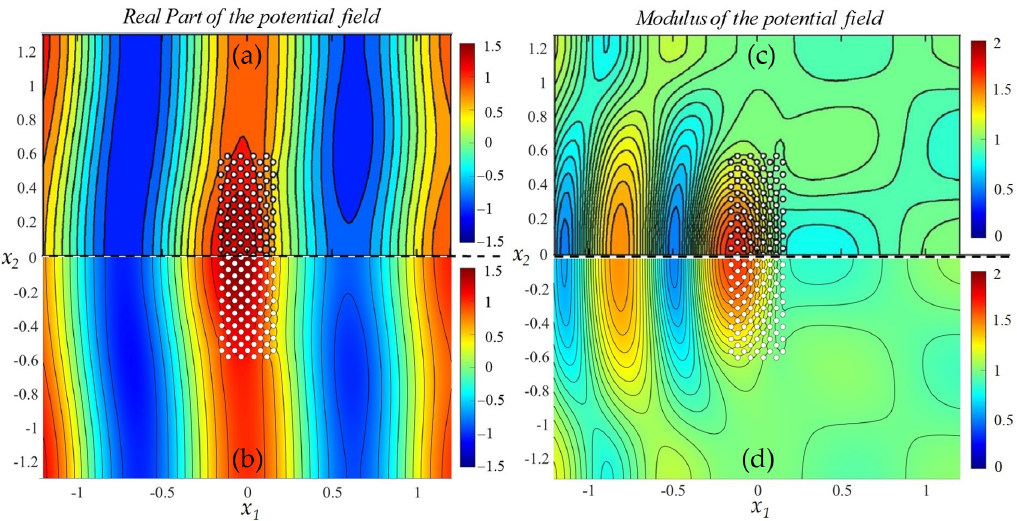
Figure 11. Real part and modulus of the symmetric wave field in the waveguide of water depth h = 0.23 m, at frequency f = 1Hz, as calculated by ( a , c ) the modal BEM developed by Belibas- sakis, et al. [4] and ( b , d ) the present FEM scheme .